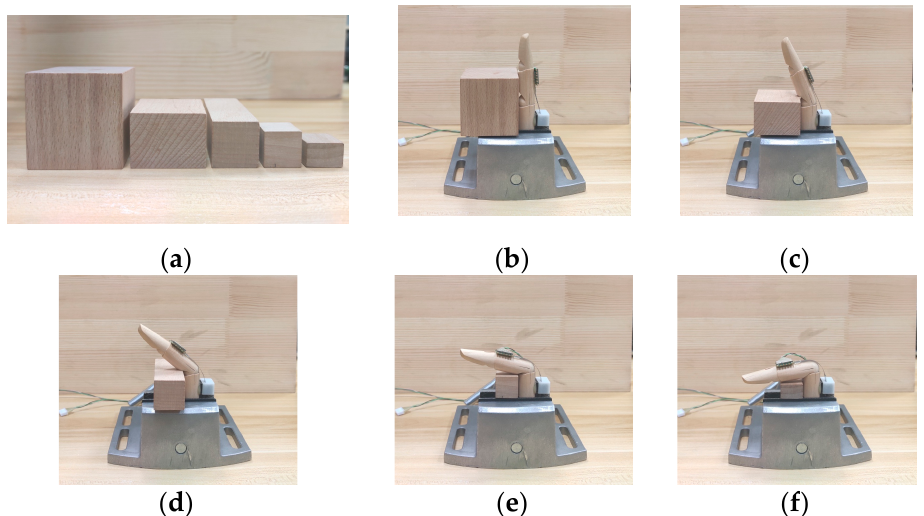
Figure 15. Calibration experiment platform. ( a ) Wooden finger model with a sensing unit and a gyroscope; ( b ) Wooden finger on the flat tongs.